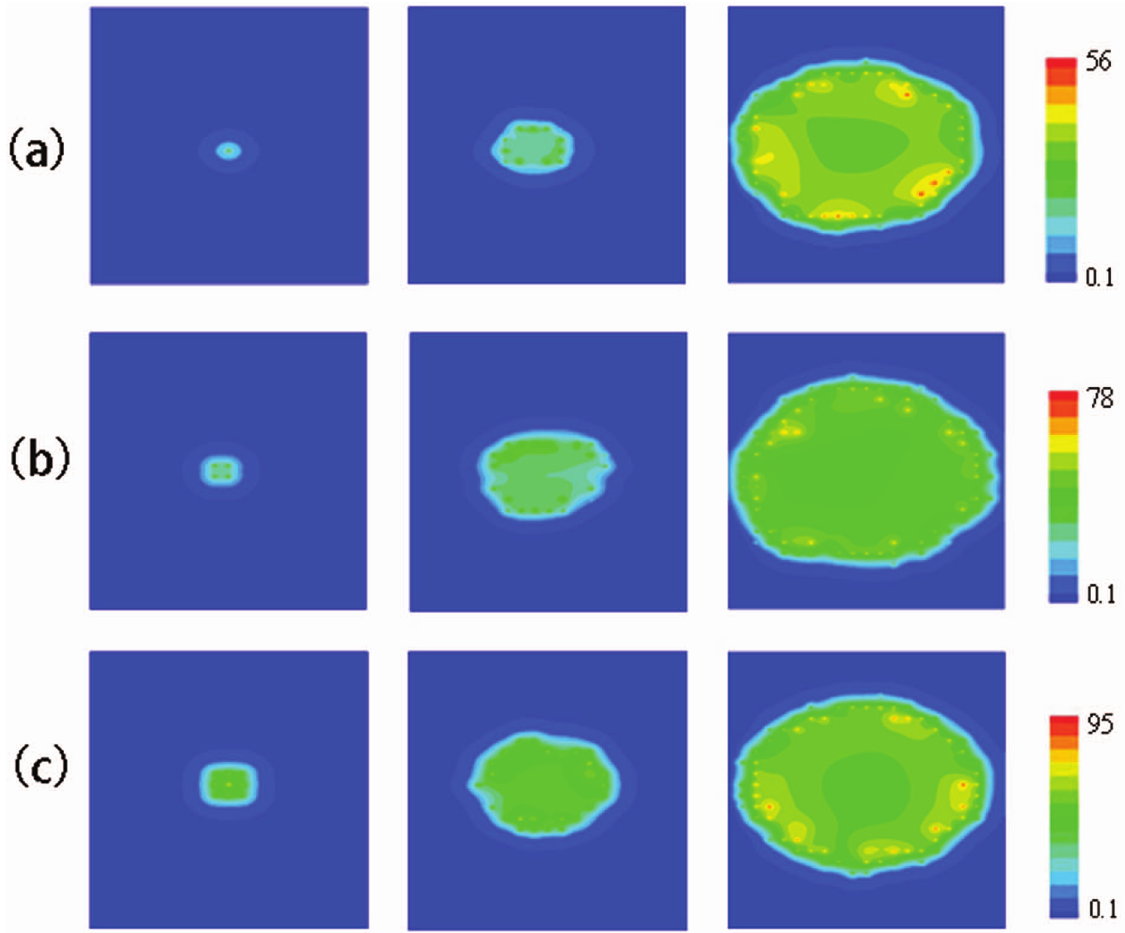
Figure 6. With smaller longitudinal intervals, the effect of initial Ca 2 z sparks numbers. (a)Snapshots of Ca 2 z waves initiating from a 10ms opening of the CRU at the point (10,9.6), snapshots was taken at 10, 60 and 110ms. (b)Snapshots of Ca 2 z waves initiating from a 10ms opening of the CRUs at the point (9,9.6), (10,9.6), (9,10.4) and(10,10.4), snapshots are taken at 10, 50 and 90ms. (c)Snapshots of Ca 2 z waves initiating from 10ms opening of the CRUs at the point (9,9.6), (10,9.6), (11,9.6), (9,10.4), (10,10.4), (11,10.4), (9,11.2), (10,11.2), (11,11.2),snapshots are taken at 10, 40 and 70ms. The value of parameters for a, b and c are b ~ 2 : 25 , I CRU ~ 2p A and l x ~ 1 : 0 m m